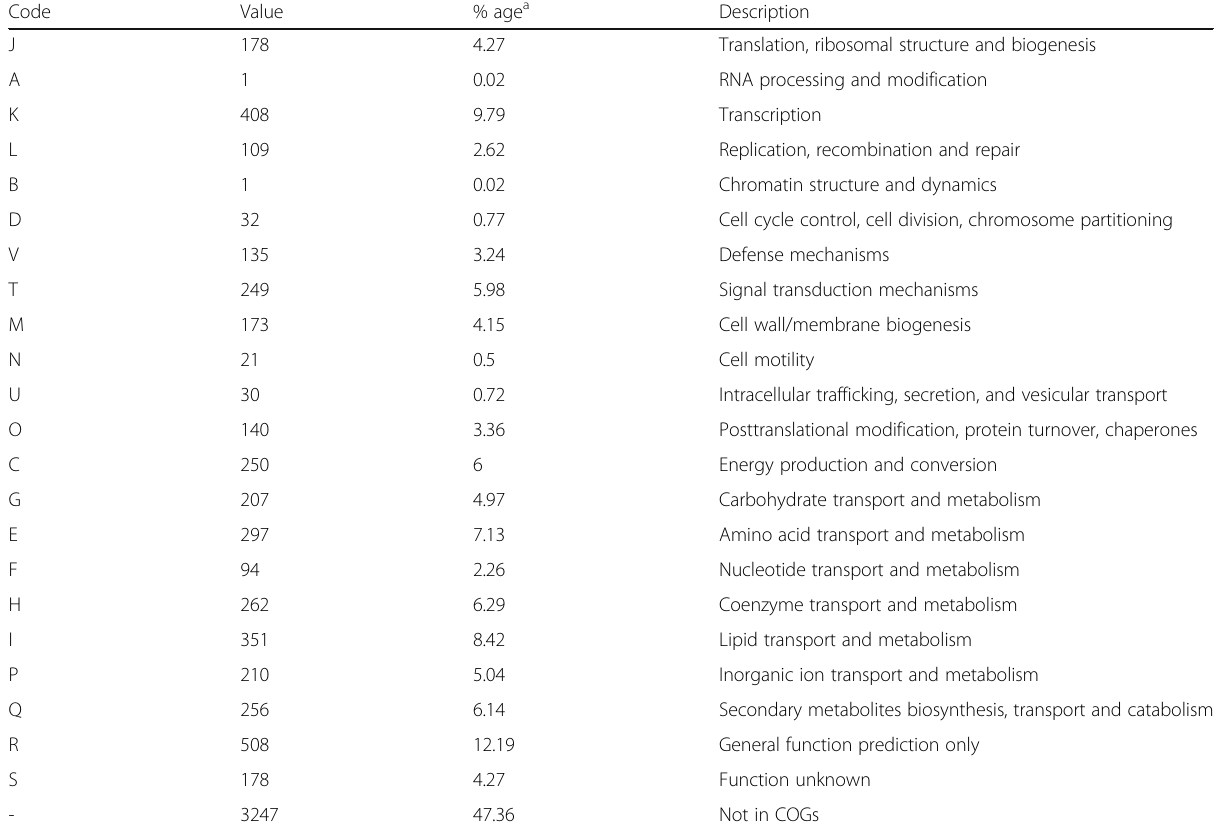
Table 4 Number of genes associated with the general COG functional